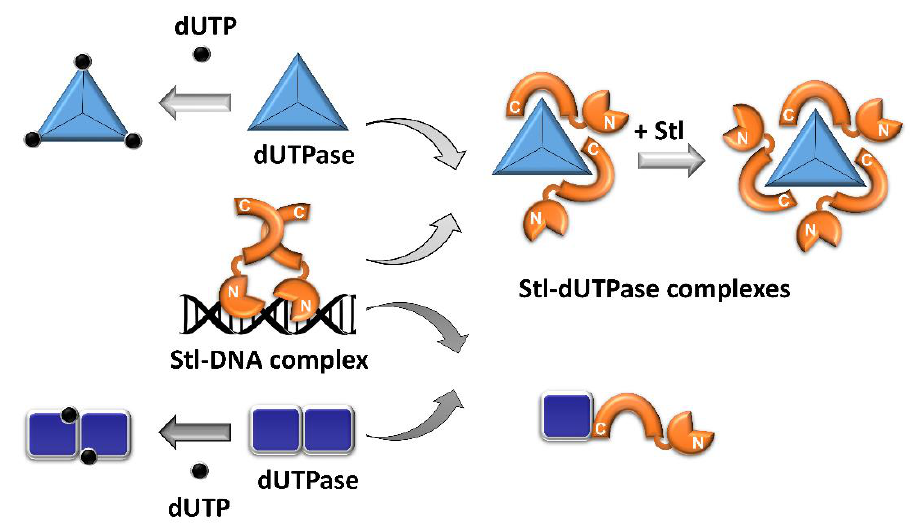
Figure S1: Annotated mass spectra of the mixture of the DUT ϕ NM1 (NM1) with Stl (STL) protein (a) and Stl protein (b) measured under native electrospray conditions. Figure S2: Coverage map of HDX-MS di ff erence plots for DUT ϕ 11 and DUT ϕ 11 ∆ insert upon complex formation with Stl. Figure S3: Active sites of DUT ϕ 11 and